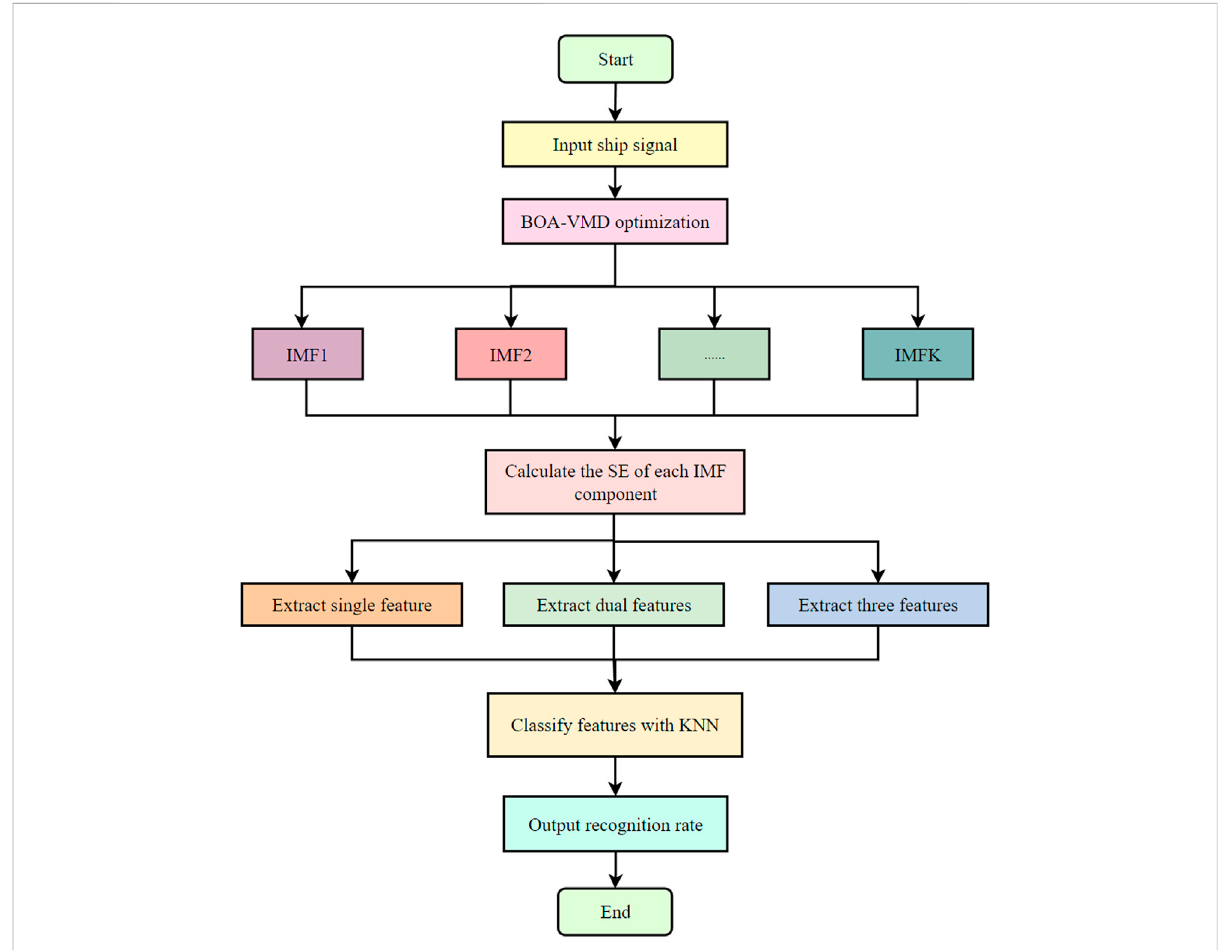
FIGURE 2 The fl ow chart of the feature extraction method of SRN based on BOA-VMD and